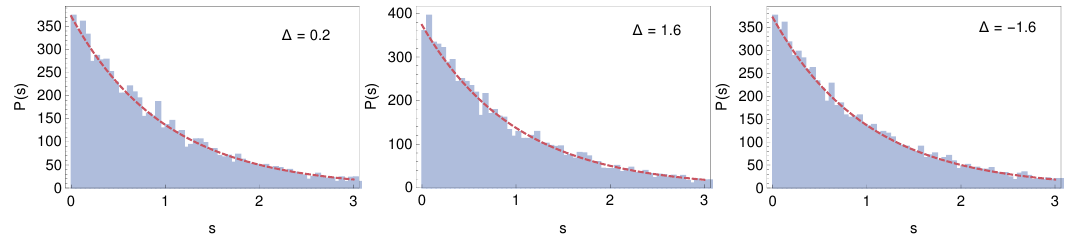
Figure 2: Level spacing statistics of the XXZ spin chain of length L = 22 for (left to right) ∆ = 0.2,1.6, − 1.6 with the exponential distribution fitted (dashed red line).